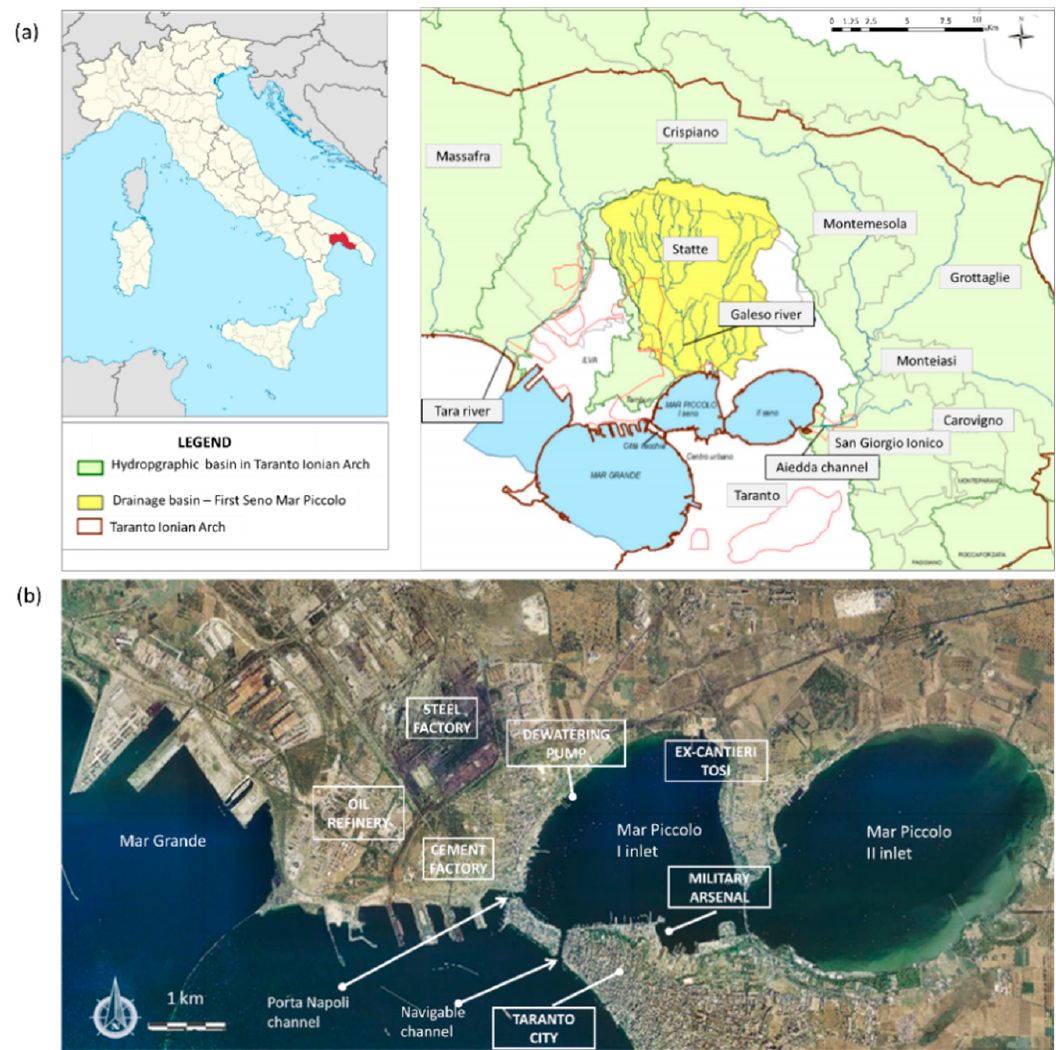
Figure 2. ( a ) Map of municipalities near the Mar Piccolo of Taranto, and ( b ) localization of industrial